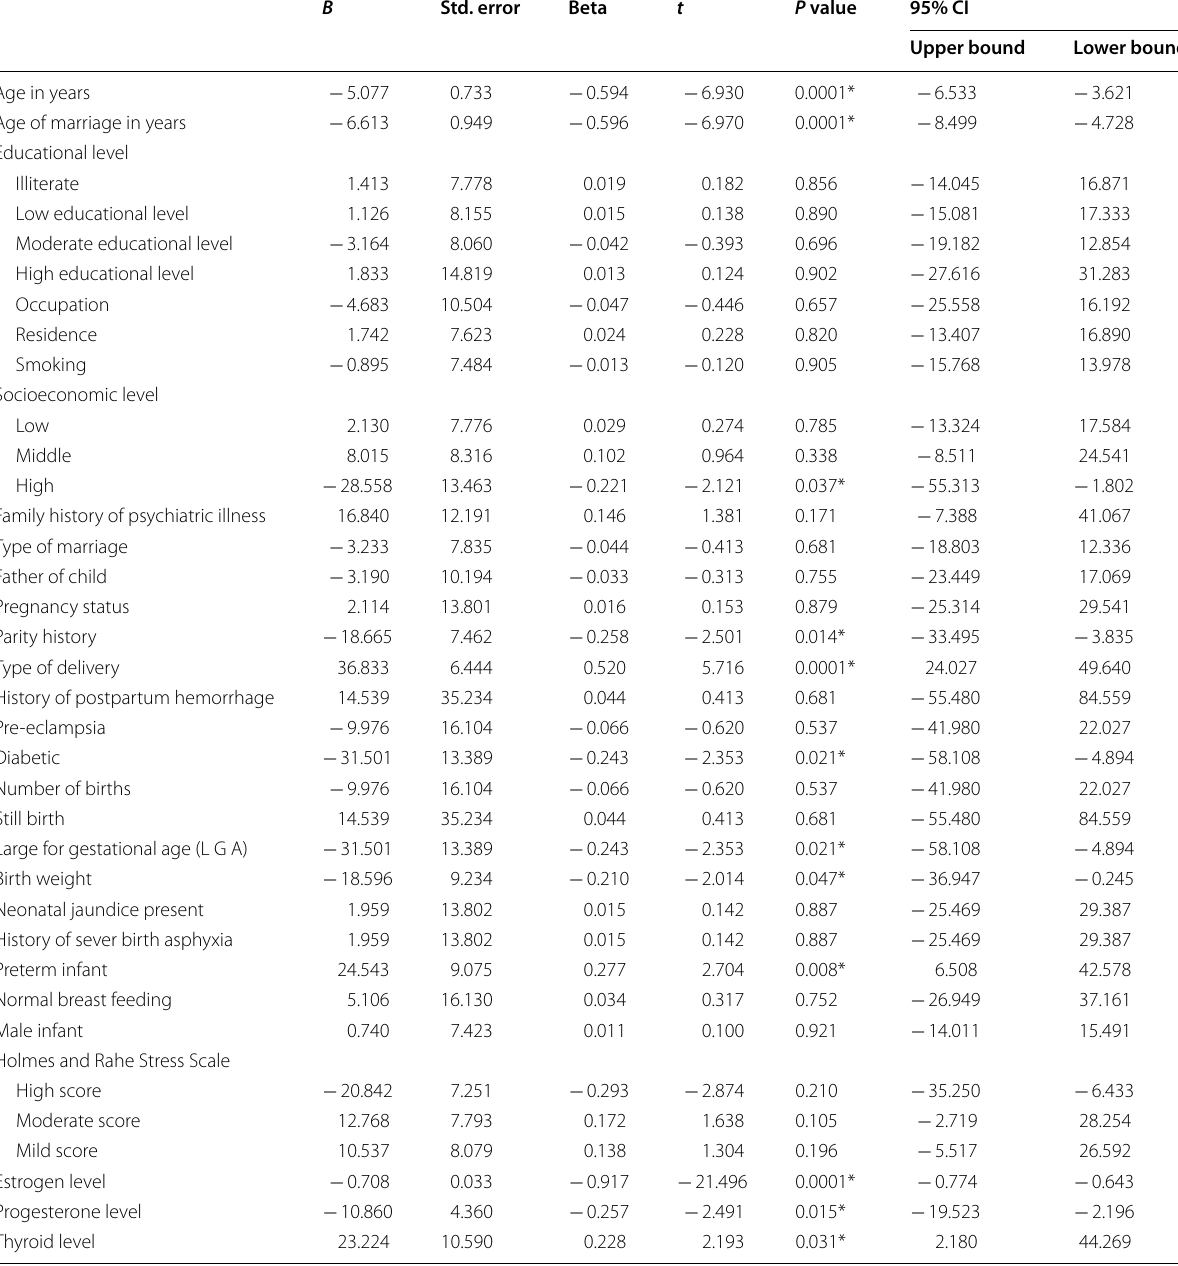
Table 5 Univariate linear regression analysis of the Brief Psychiatric Rating Scale with other